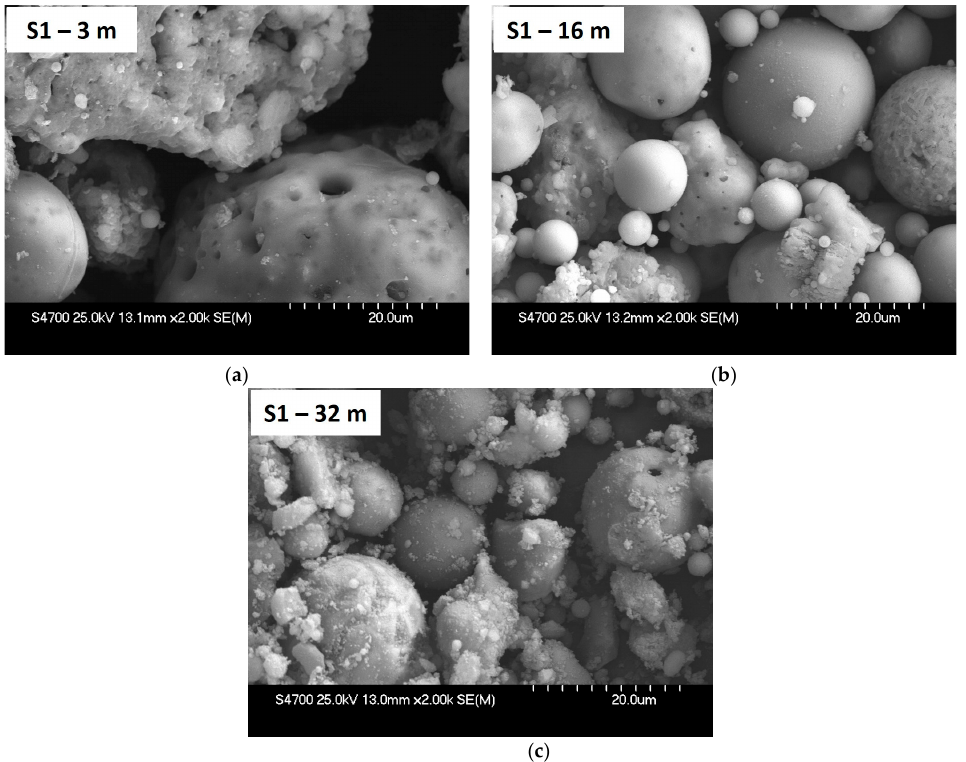
Figure 8. SEM Images of Agglomerates from Core Borehole V3 from Depths 4 m ( a ), 12 m ( b ), 25 m ( c ), magnified 2000× and 36 m ( d ), magnified 500×.